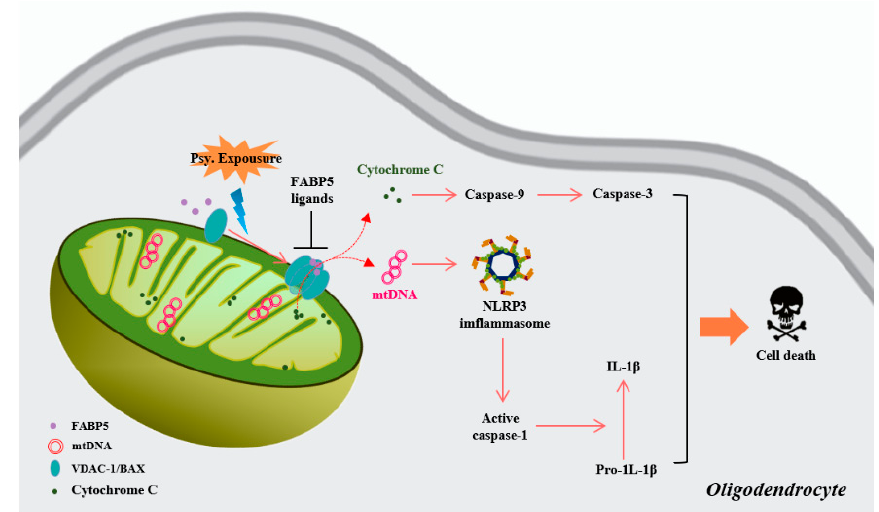
Figure 6. Schematic representation of the pathways through which FABP5 facilitates mitochondrial macropore formation and induces oligodendrocyte apoptosis. During psychosine exposure, FABP5 abnormally accumulates in mitochondria and facilitates mitochondrial macropore formation via VDAC-1 oligomers and BAX. Furthermore, cytosolic cytochrome C and mtDNA released from mitochondrial pores trigger NLRP3 inflammasome-dependent and caspase-dependent apoptosis. In addition, pharmacological inhibition of FABP5 by FABP5 ligands blocks mitochondrial macropore formation, thereby rescuing oligodendrocytes. Figure S1: FABP7 does not localize in mitochondria, even when treated with psychosine. (A) Confocal microscopy of FABP7 (red), Mito-tracker (green), and actin (cyan), showed no co-localization of FABP7 with mitochondria. Scale bar = 50 µ